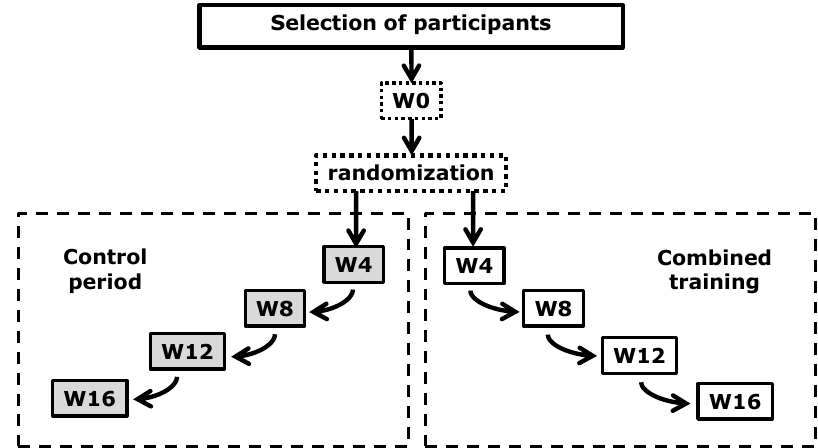
Figure 2. Experimental design. W: weeks of assessments; 0, 4, 8, 12 and 16 weeks along control and combined training period.